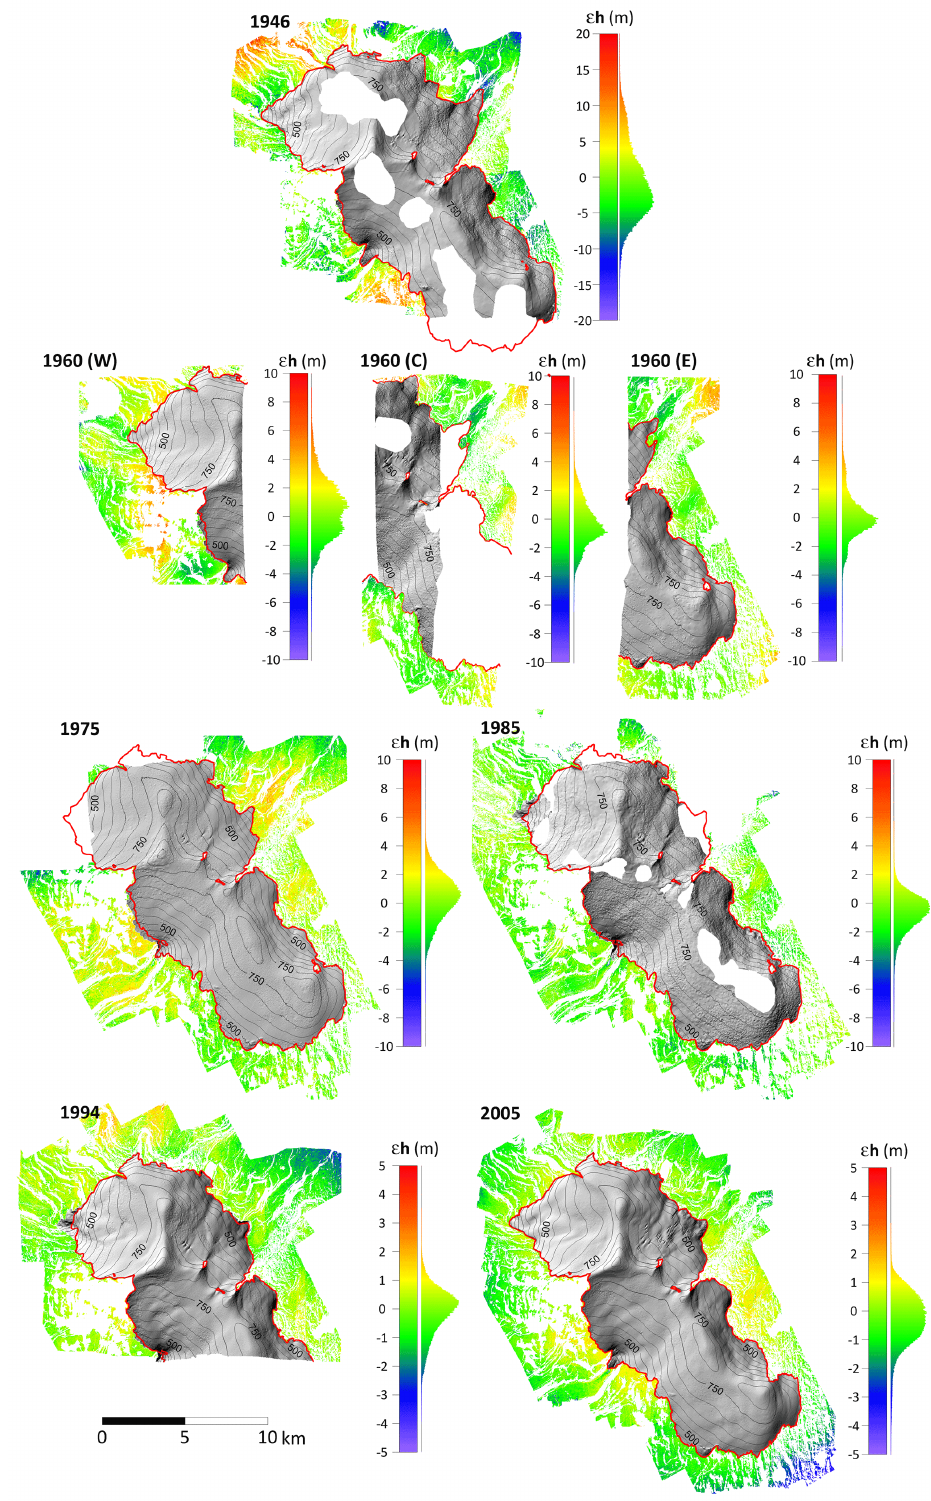
Figure 3. The series of DEMs of Drangajökull ice cap created from the aerial photographs. The shaded relief images and contour maps indicate the glaciated part of each DEM. The elevation difference off ice (after masking out outliers and areas with slope>20 ◦ ) are shown as color images. The color scale is extended for the DEM in 1946 and reduced for the 1994 and 2005 DEMs. A vertical histogram next to the scale bar shows the error